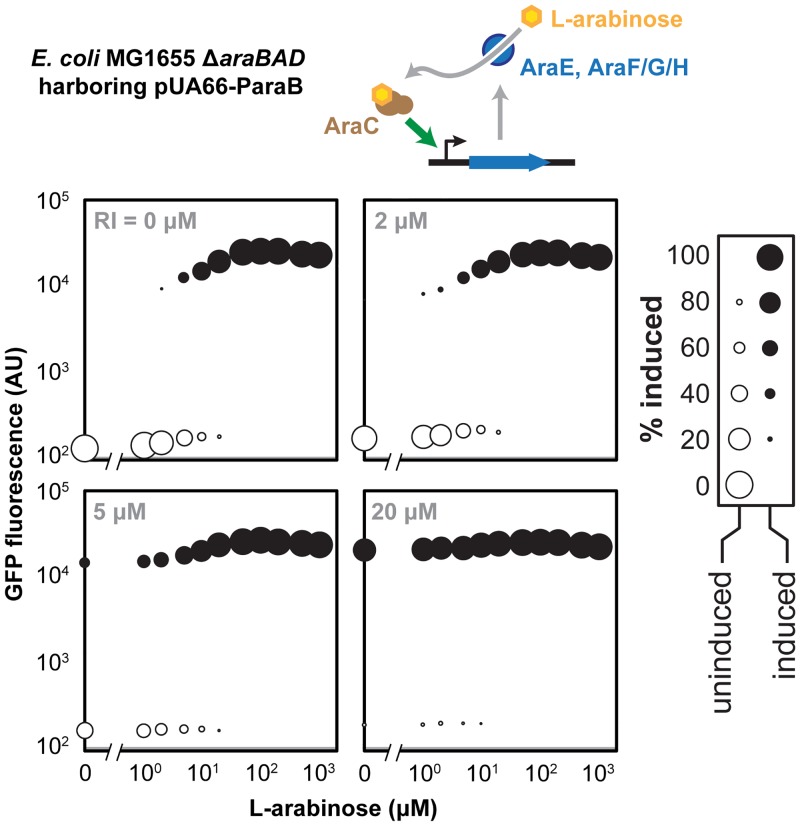
Impact of residual inducer on an “all-or-none” system in E. coli.(A) Dot plots for E. coli MG1655 ΔaraBAD cells harboring pUA66-paraB with the indicated concentration of residual L-arabinose. Filled and empty circles represent the induced and uninduced sub-populations, respectively. The size of the dot reflects the proportion of cells in the sub-population, whereas the height of the dot reflects the mean fluorescence of the sub-population. The gray bar represents the measured fluorescence of the same E. coli cells harboring pUA66. Values are representative of independent experiments starting with at least three separate colonies.